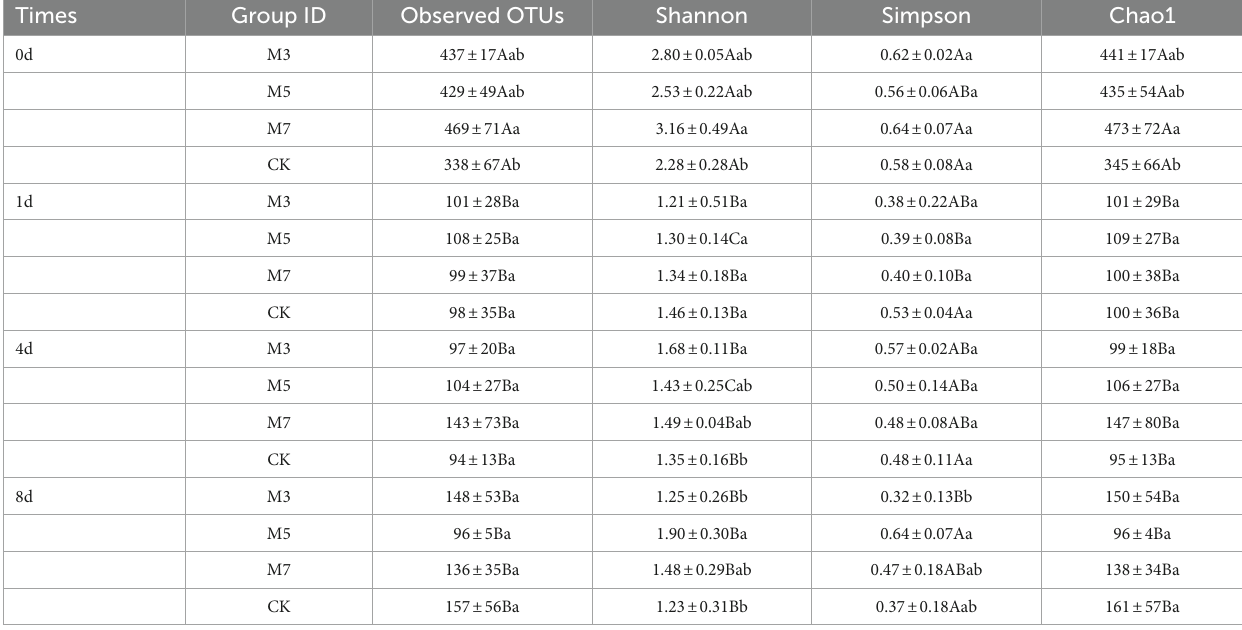
Mean ± SD ( n = 3); Different capital letters represent significant differences in different periods of the same group ( P < 0.05), Different lowercase letters represent significant differences between groups at the same time ( p < 0.05), while the same letter indicated no significant difference( P > 0.05).